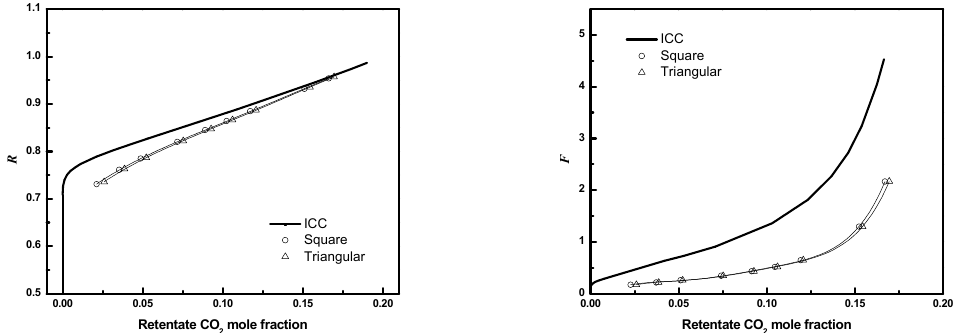
Figure 22. R or F as a function of CO 2 mole fraction for full 3-D circular square configuration module and equilateral triangular configuration module ( N = 405, D / R f = 3, φ = 0.6. Circle, square configuration; up triangle, triangular configuration; solid line, ICC).